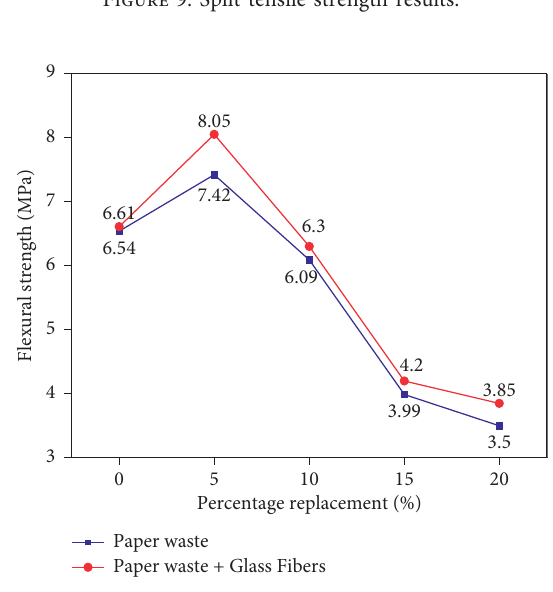
Figure 9: Split tensile strength results.